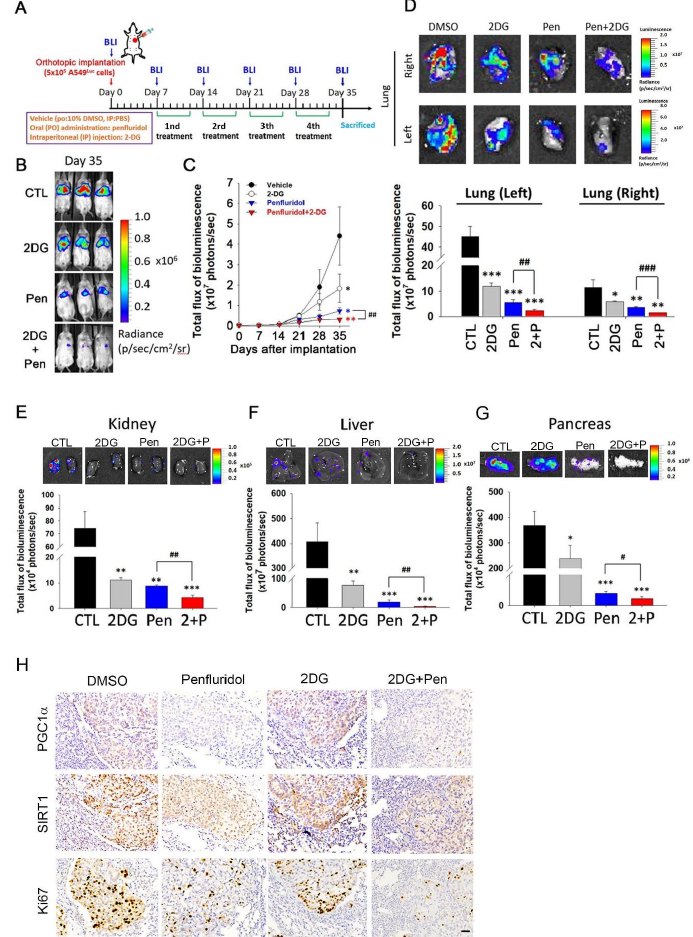
Figure 5. 2 − Deoxy − D − glucose (2DG) promotes the oncostatic effect of penfluridol in an A549 orthotopic graft model. ( A ) Timeline of the in vivo study design for investigating the antitumor activity of penfluridol, 2DG, and penfluridol+2DG on tumor progression. Male NOD/SCID mice were orthotopically injected with luciferase − tagged A549 cells. After 7 days, mice were treated with penfluridol (5 mg/kg, orally), 2DG (100 mg/kg, intraperitoneally), penfluridol+2DG, or the vehicle 5 days/week for 4 consecutive weeks. All mice were sacrificed at 4 weeks after drug treatment, and the luciferase activity was detected every week with a noninvasive imaging system (IVIS imaging system, Xenogen). ( B , C ) Bioluminescence imaging of orthotopic lung tumor growth at the end of the experiment ( B ). Quantitative analysis of Xenogen imaging signal intensity at the indicated time points ( C ). * p < 0.05; ** p < 0.01 compared to the vehicle control group; ## p < 0.01 compared to the penfluridol-treated group. ( D ) Lungs were isolated and examined at the end of the experiment. Upper panel: Cancer metastasis from the left lung to the right lung was imaged with bioluminescence at the end of the experiment. Lower panel: Signal intensities from primary tumors (left lung) and metastatic tumors (right lung) were captured with bioluminescence at the end of the experiment, with the mean signal for each group indicated. * p < 0.05, ** p < 0.01, *** p < 0.001 compared to the vehicle control group. ## p < 0.01, ### p < 0.001, compared to the penfluridol-only-treated group. ( E – G ) Representative ex vivo bioluminescence imaging of distal metastatic sites. Signal intensities from distal metastatic organs including the kidneys ( E ), liver ( F ), and pancreas ( G ) were captured with bioluminescence, with the mean signal for each group indicated. * p < 0.05, ** p < 0.01, *** p < 0.001 compared to